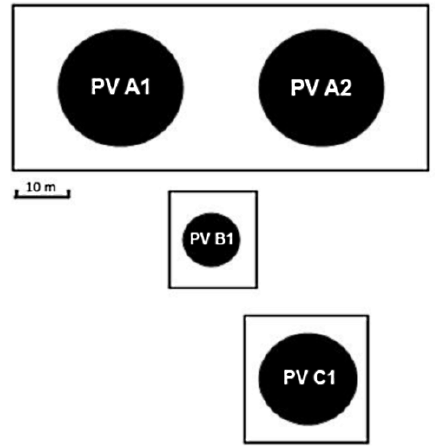
Fig. 7. Layout of the plant considered in case study 1.